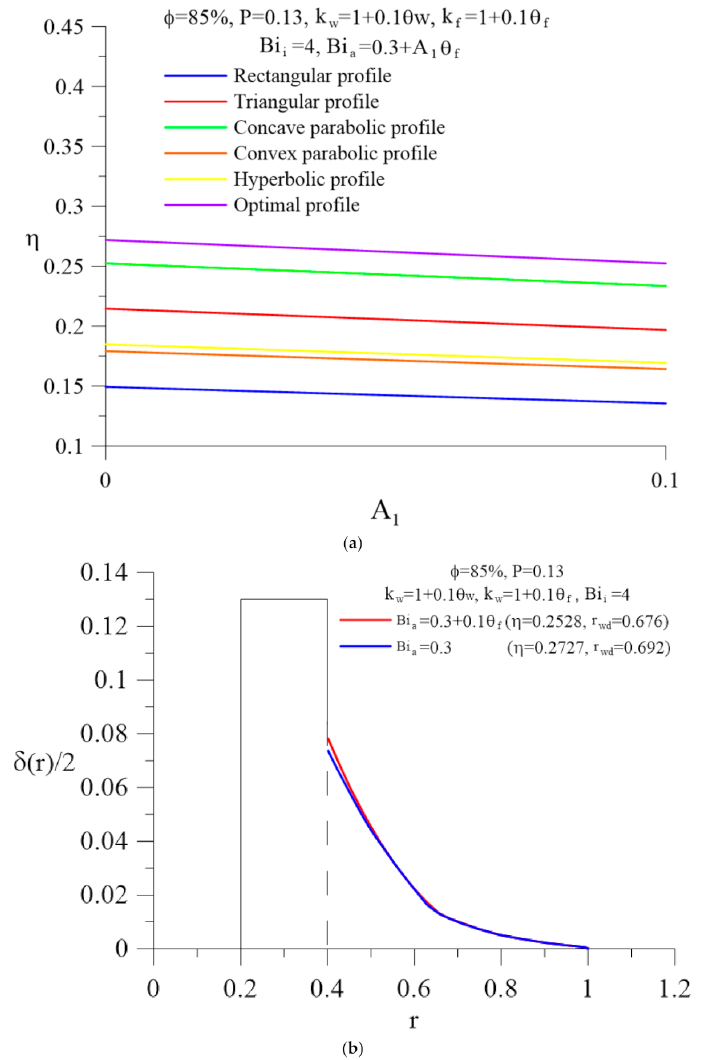
Figure 6. ( a ) The comparisons of η for different types of partially wet annular fins.with various Bi a . ( b ) The estimated optimum fins with various Bi a